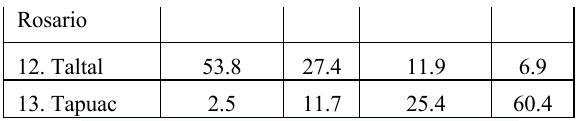
Table 8. Percentage of area affected by flood in Masinloc